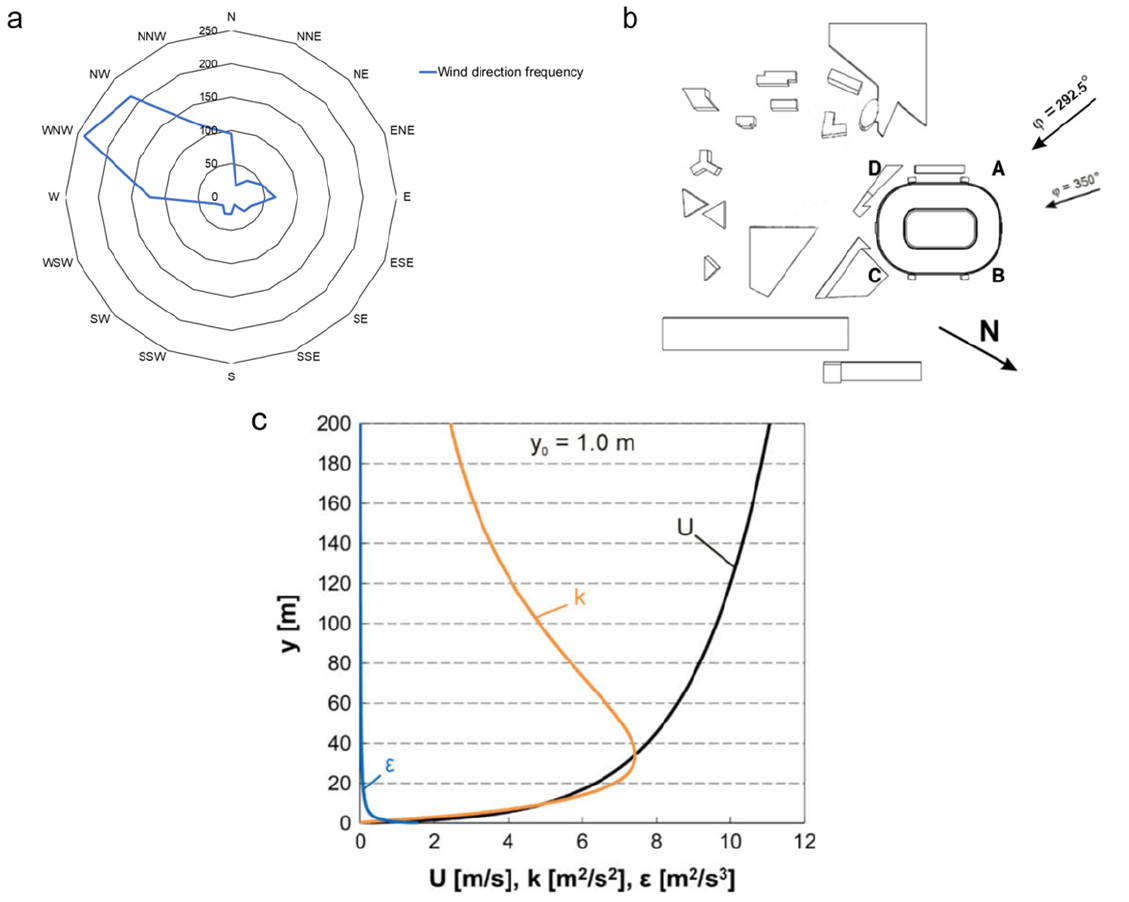
Energies 2021 , 14 , x FOR PEER REVIEW Figure 4. ( a ) The frequency of wind direction during the match period. ( b ) The wind direction in the simulation (where A–D are the four gates of the stadium). ( c ) Approach wind velocity profiles, turbulence kinetic energy, and dissipation rate [14].